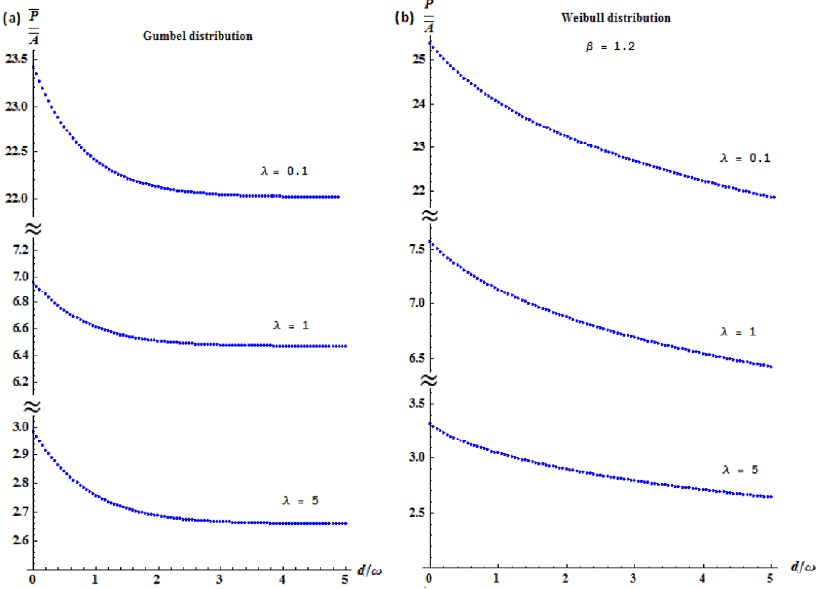
Fig. 7 (a) Gumbel distribution: pressure versus separation for contacts with different values of the adhesion parameter λ . For adhesive contacts, pressure has a lower value. (b) Weibull distribution β = 1.2, pressure versus separation for contacts with different values of the adhesion parameter λ